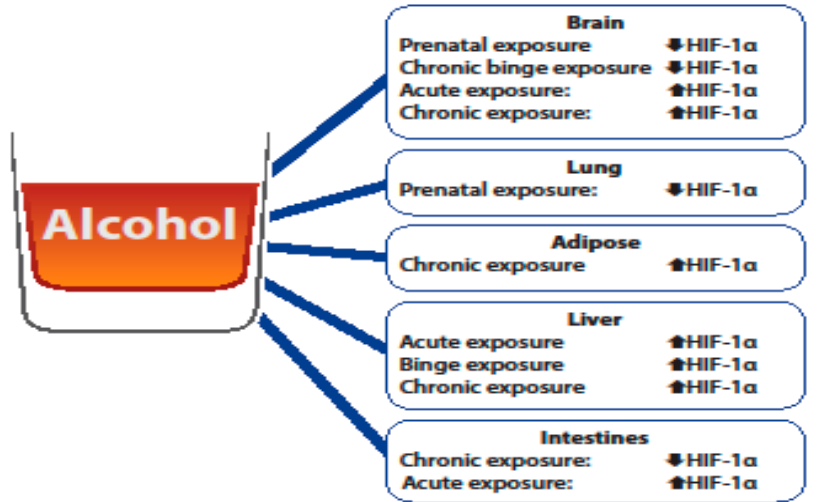
Figure 1. Overview of the differential effects of alcohol of hypoxia-inducible factor (HIF)-1 α levels.